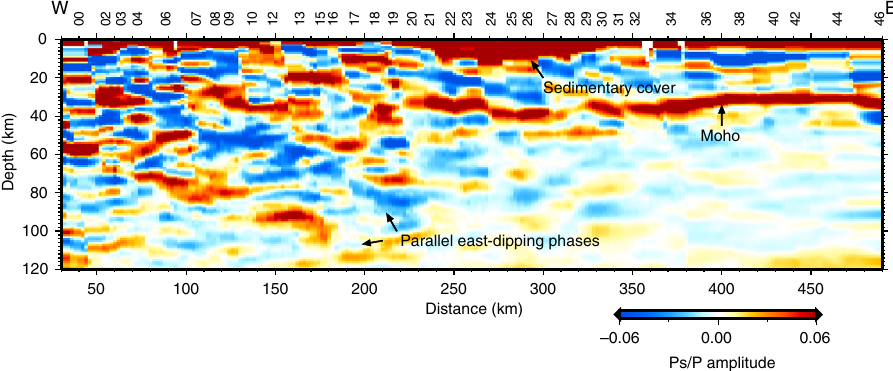
Fig. 2 Initial common conversion point (CCP) image along the Central Myanmar Seismic Pro fi le. The CCP image is generated using a prior one- dimensional model as the migration model. Red colors denote positive receiver function amplitudes as indicated by the color bar, and blue colors denote negative